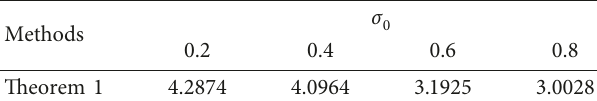
Table 2: The MAUBs of d d K , and η . I , 1